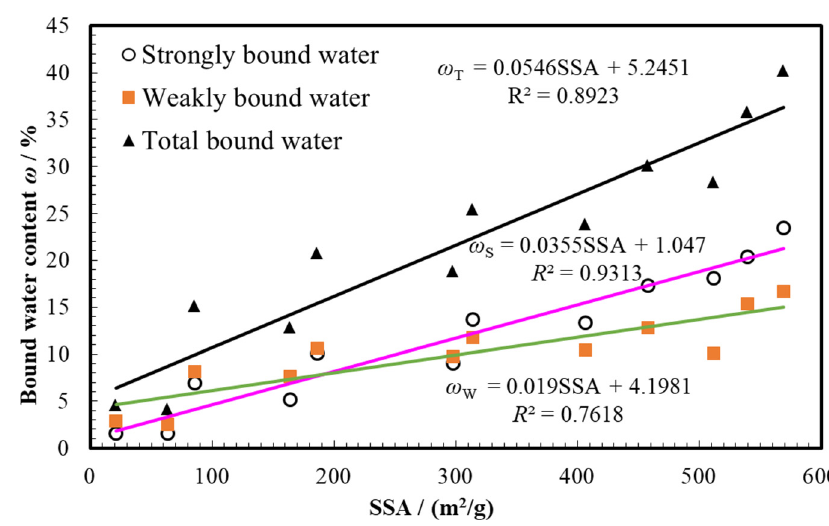
Figure 6. Relationship between bound water and SSA of soils.